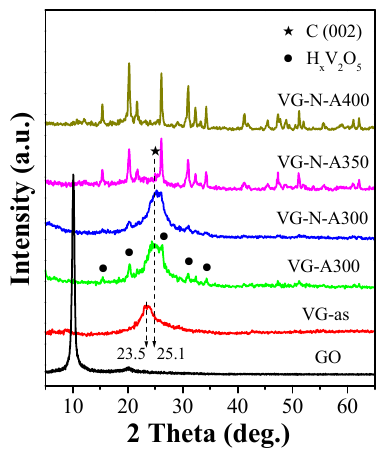
Scheme 1. Schematic illustration of the synthesis process of vanadium oxide / reduced graphene oxide (VO x / RGO) composites. Catalysts 2016 , 6 , 74